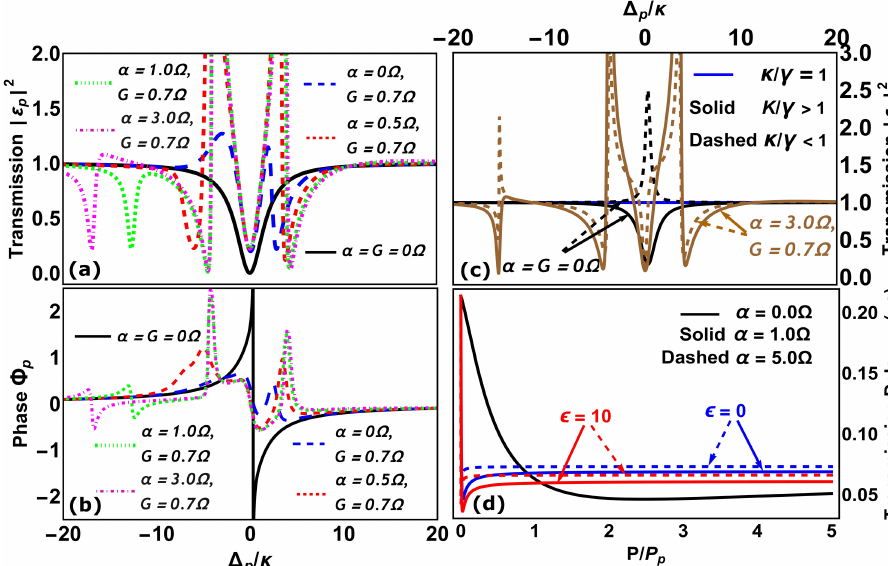
Fig. 2 SO-coupling induced quantum nonlinear optics. a The transmission amplitude jE p j 2 and b phase Φ p versus Δ p / κ , for various values of G / Ω and α / Ω at ε / κ = 1. c jE p j 2 versus Δ p / κ in balanced κ / γ = 1 (blue), lossy κ / γ > 1 (solid) and gain κ / γ < 1 (dashed) regimes with absence (black) and presence (brown) of SO-coupled BEC. d The transmission delay τ g versus pump power P / P p illustrating the in fl uences of ϵ and α / Ω . The other parameters used are Ω z = Ω , δ = 0, U / Ω = 5.5, Δ = 1.5 κ and Ω = 3.8 × 2 π MHz 87,88 p ffiffiffiffiffiffiffiffiffiffiffiffiffiffiffiffiffi Ω _ = m and cavity bec